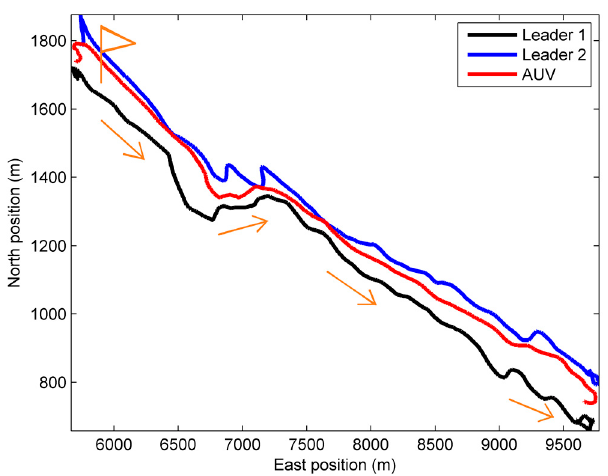
Figure 6. True trajectory of two leaders and a slaver autonomous underwater vehicles (AUVs).